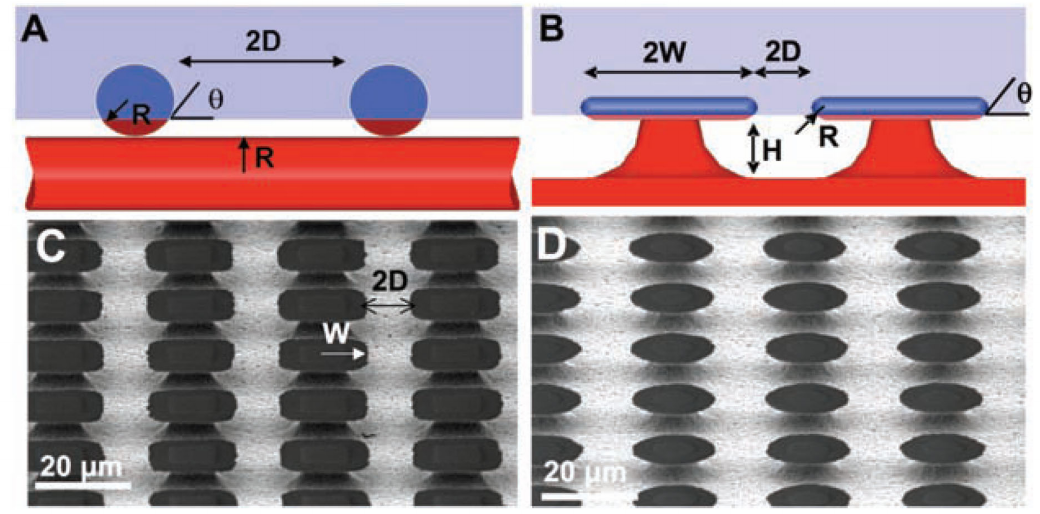
Figure 18. Critical role of re-entrant curvature. ( A ) and ( B ) Cartoons highlighting the formation of a composite interface on surfaces with re-entrant topography, for both fibers and microhoodoos. The geometric parameters R, D, H, and W characterizing these surfaces are also shown. The blue surface is wetted while the red surface remains unwetted when in contact with a liquid whose equilibrium contact angle is θ < 90 ◦ . ( C ) and ( D ) SEM micrographs for two microhoodoo surfaces having square and circular flat caps,